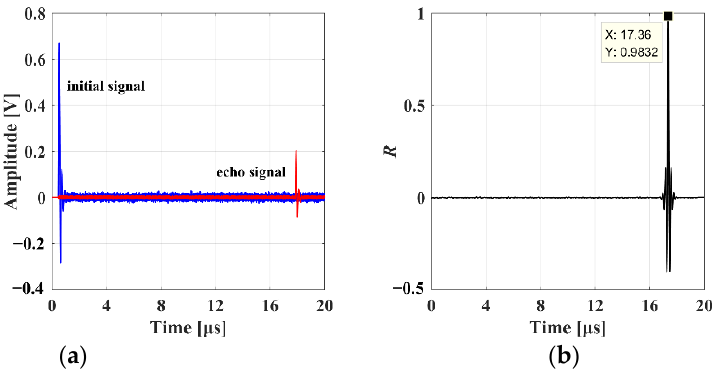
Figure 2. The correlation calculation result of a simulated signal: ( a ) the waveform of the simulated signal; ( b ) the correlation coefficient distribution.